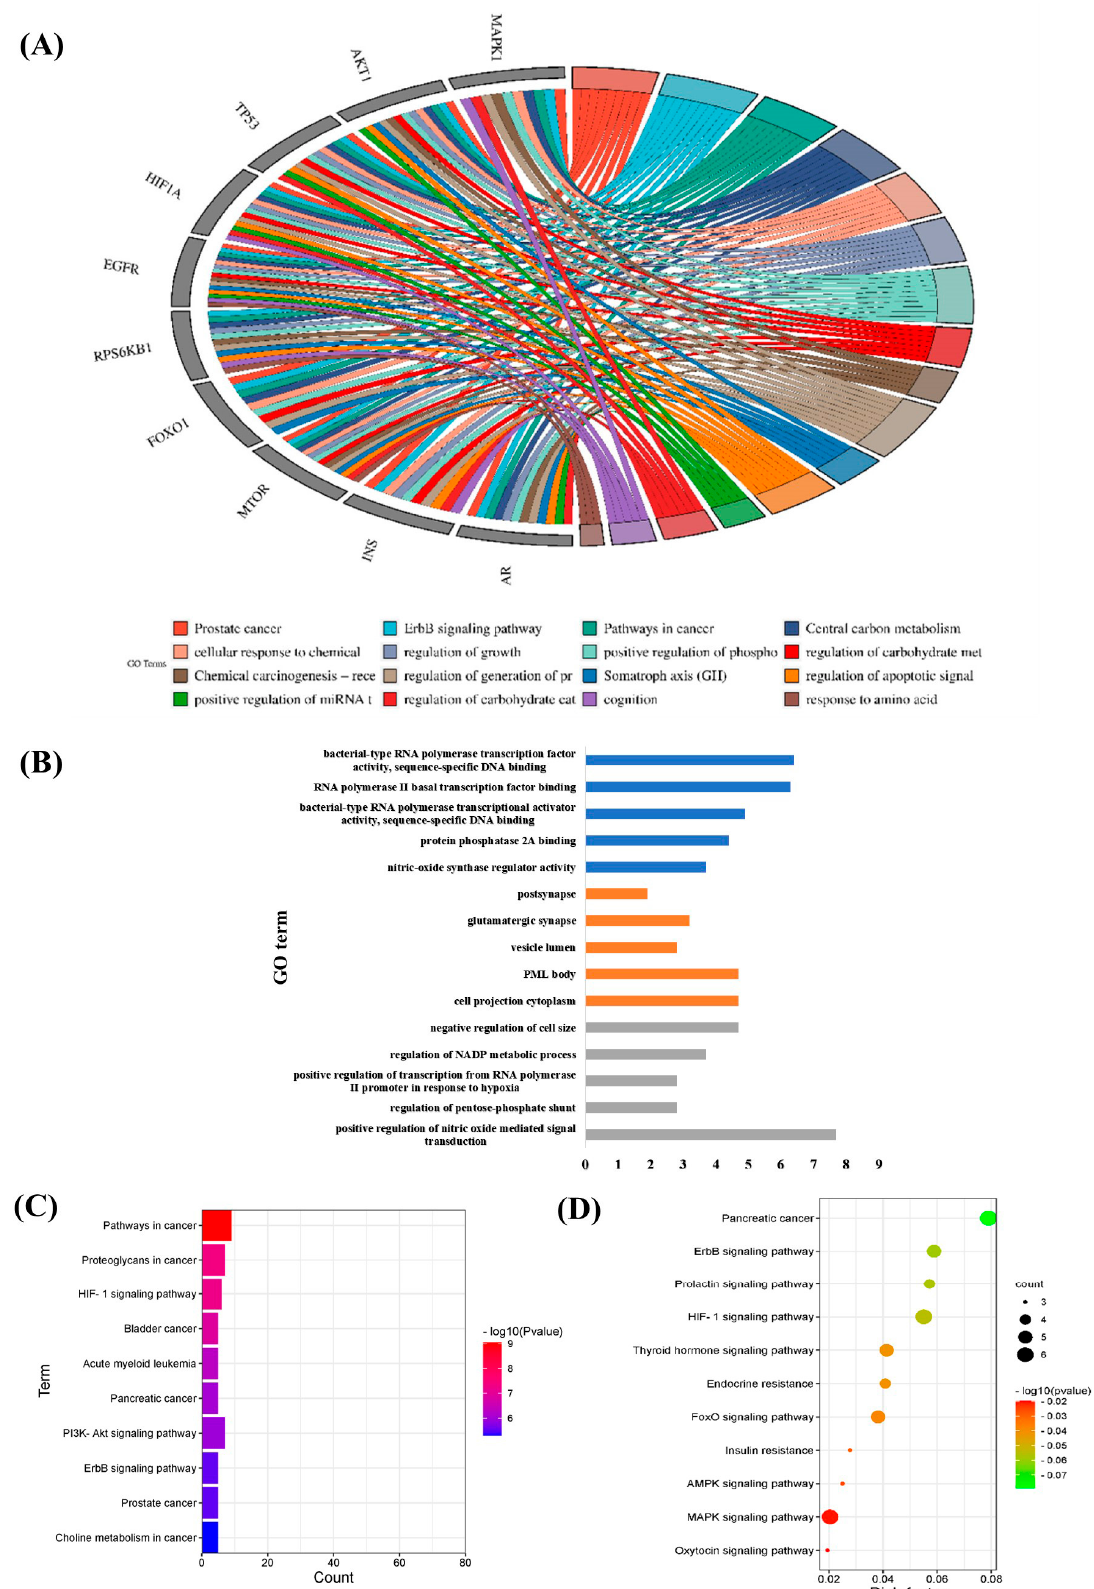
Figure 3. The Gene Ontology (GO) and the Kyoto Encyclopedia of Genes and Genomes (KEGG) pathway enrichment analyses of 10 significant genes. ( A ) The GO enrichment analyses of 10